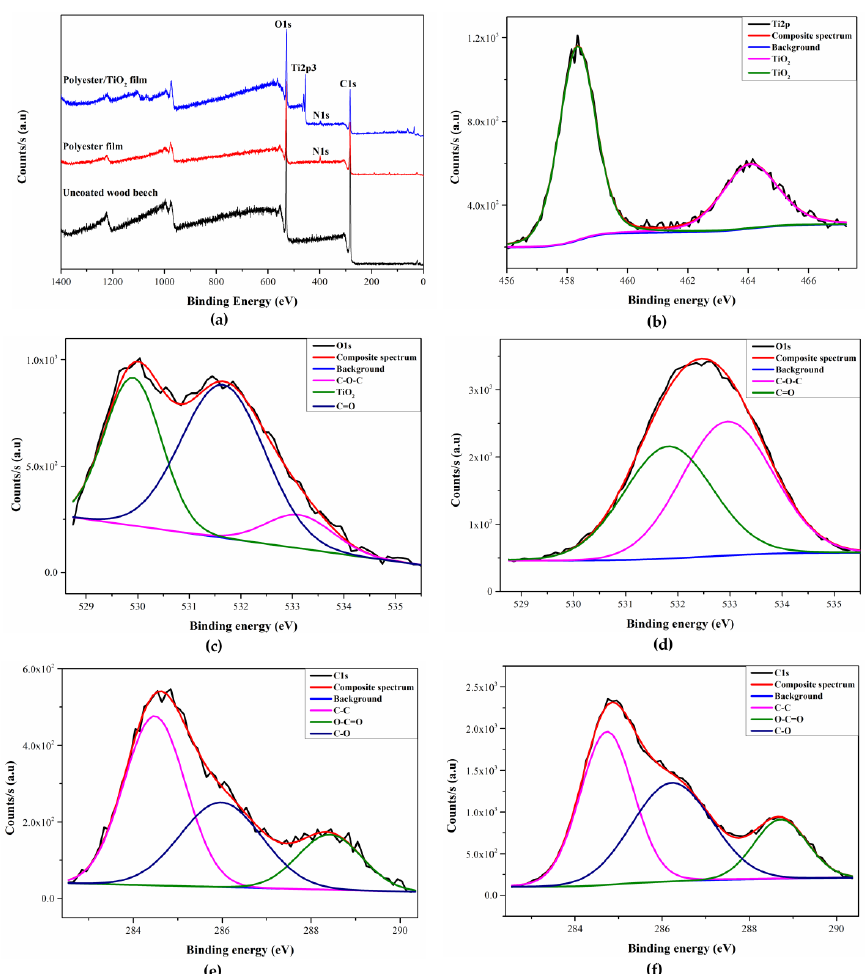
Figure 5. XPS survey spectra and high resolution XPS spectra of the uncoated wood, polyester-coated wood and polyester/TiO 2 -coated wood; ( a ) survey spectra; ( b ) high-resolution XPS spectra of Ti 2p; ( c ) O 1s for polyester/TiO 2 film; ( d ) O 1s for polyester film; ( e ) C 1s for polyester/TiO 2 film; ( f ) C 1s for polyester film.